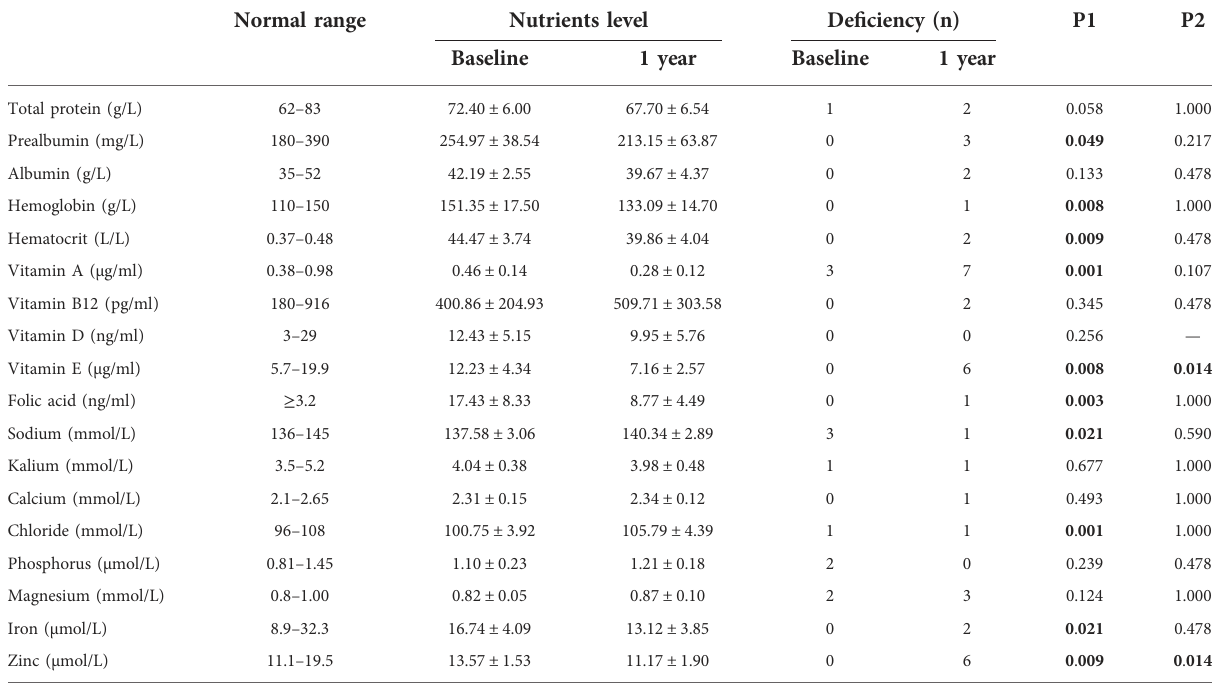
TABLE 2 Changes of nutrients ’ serum levels at 1 year after BPD-DS ( n =12). Normal range Nutrients level De fi ciency (n)